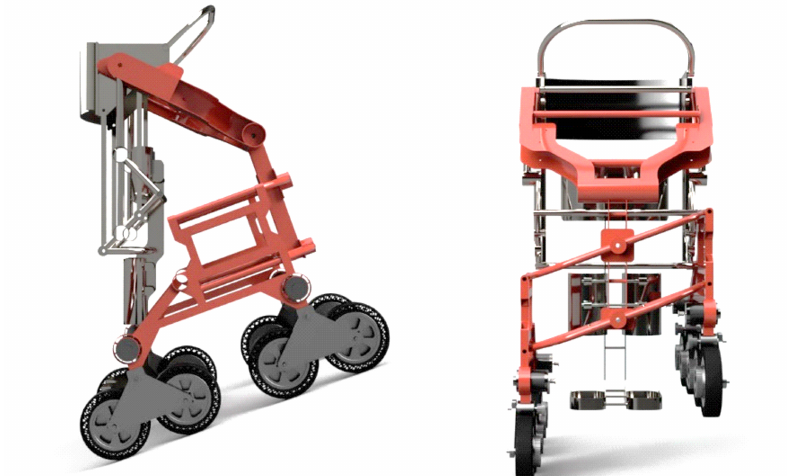
Figure 6. Model of the stabilizing mechanism. ( Left ) Coronal, ( Right )